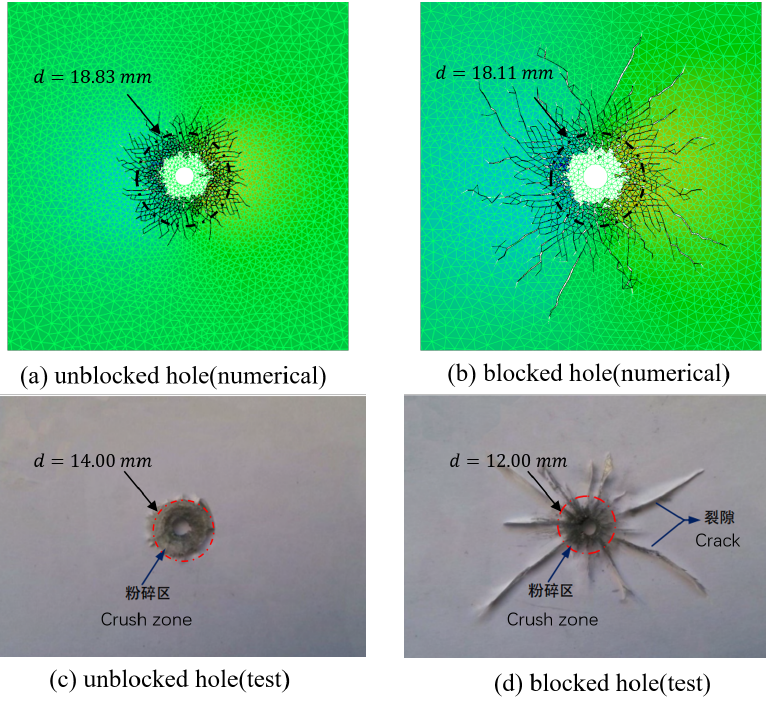
Figure 6. Cracking pattern. Considering the blocked condition, the evolution of gas pressure is shown in Figure 7.